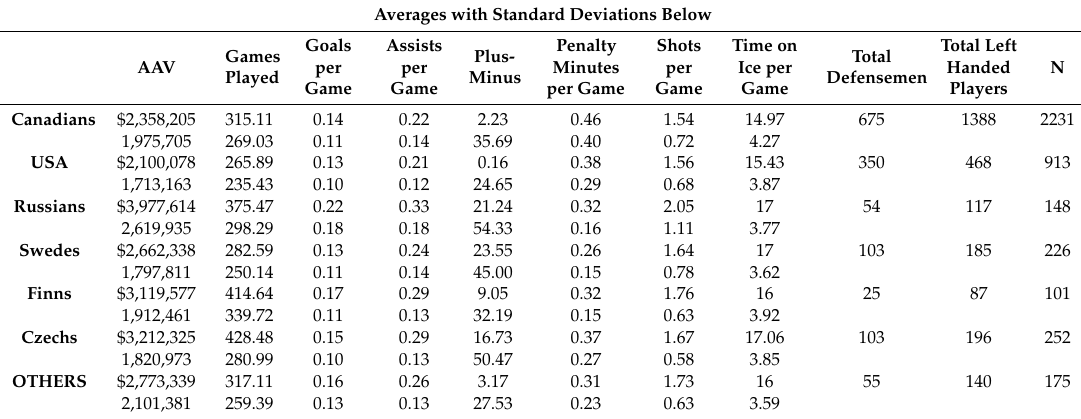
Table 1. Sample statistics by country (career lagged